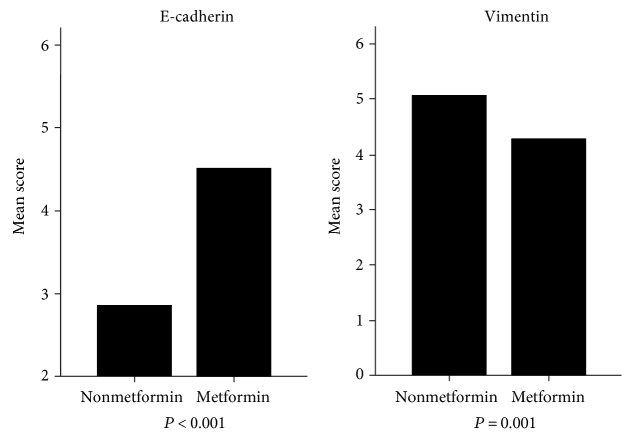
IHC scores of E-cadherin and vimentin in CRC tissues from patients with or without metformin: compared with patients without metformin, patients with metformin expressed higher E-cadherin (P < 0.001) and lower vimentin (P = 0.001).